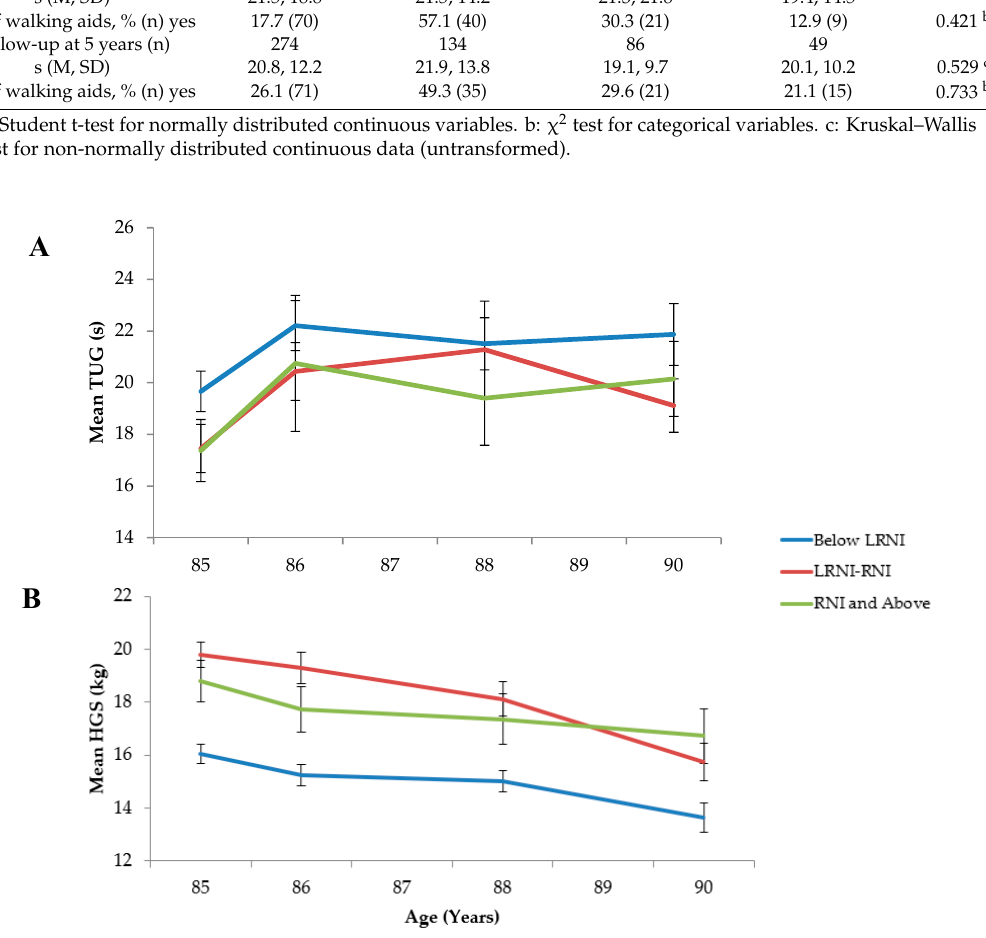
Figure 2. Mean hand grip strength (HGS) ( A ) and timed-up-and-go (TUG) ( B ) values across 5 years divided by selenium intakes: below lower reference nutrient intake (LRNI) (below 40 µ g / d), LRNI-reference nutrient intake (RNI) (between 40 and 59 and 40 and 74 µ g / d for women and men, respectively) and RNI and above ( ≥ 60 and ≥ 75 µ g / d for women and men, respectively). Time intervals between each measurement were not consistent: 0, 1.5, 3 and 5 years.